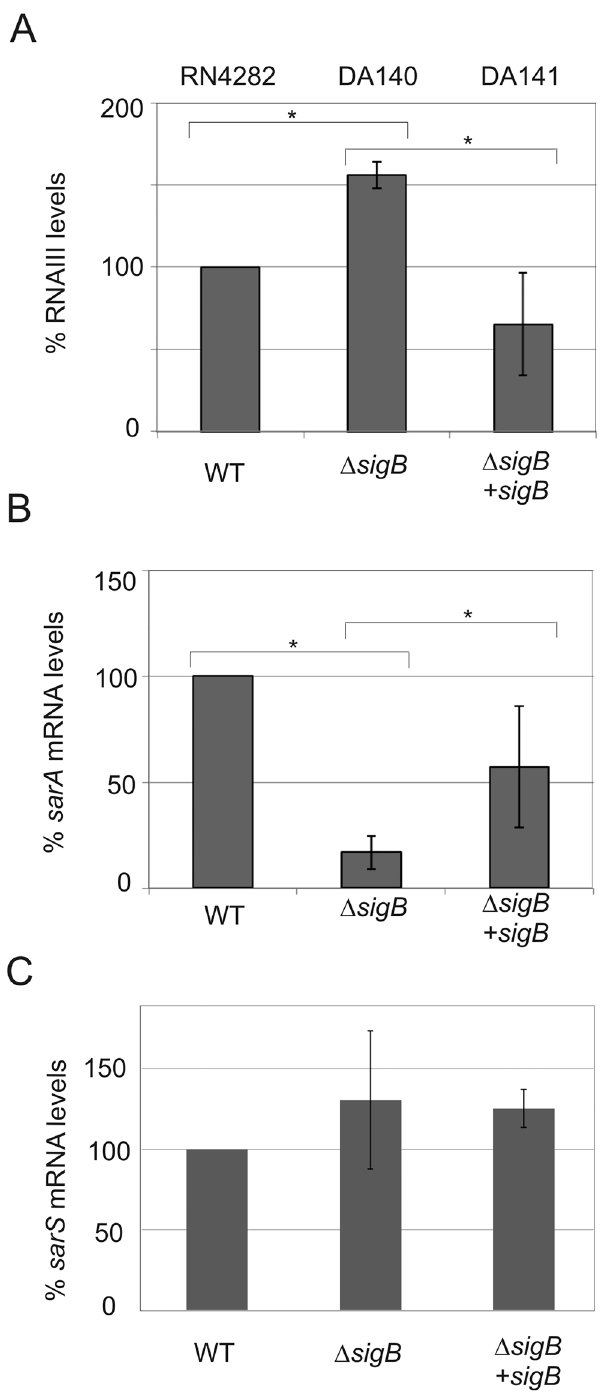
Fig 2. The effect of sigB disruption on RNAIII (A), sarA (B) and sarS (C) transcript levels in RN4282 and its derivatives using quantitative qRT-PCR measurements of RNA expression. Relative changes are shown in each panel using RN4282 as 100%. Bars show +/- standard deviations and all data were compiled from three independent experiments. Statistical significance was evaluated by Student ’ s paired t test, and data were considered significant when P was <